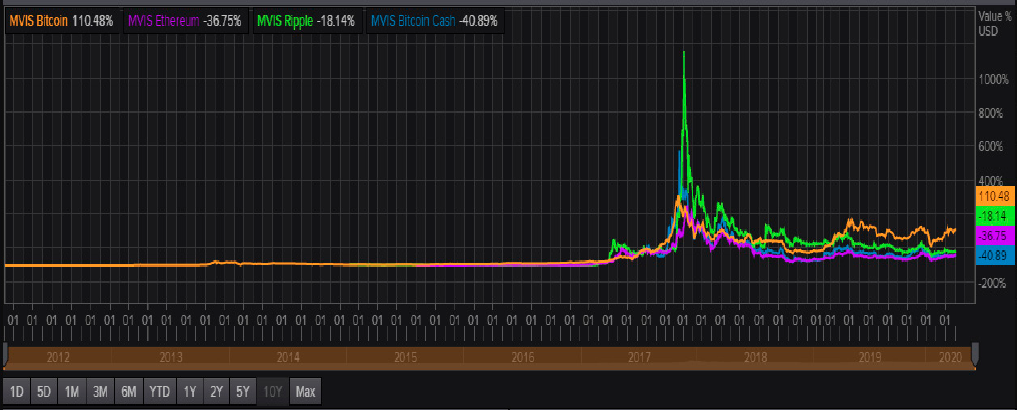
Figure 4. The evolution of worldwide cryptocurrencies, 2012–2020. Source: Authors’ own processing based on Thomson Reuters data.